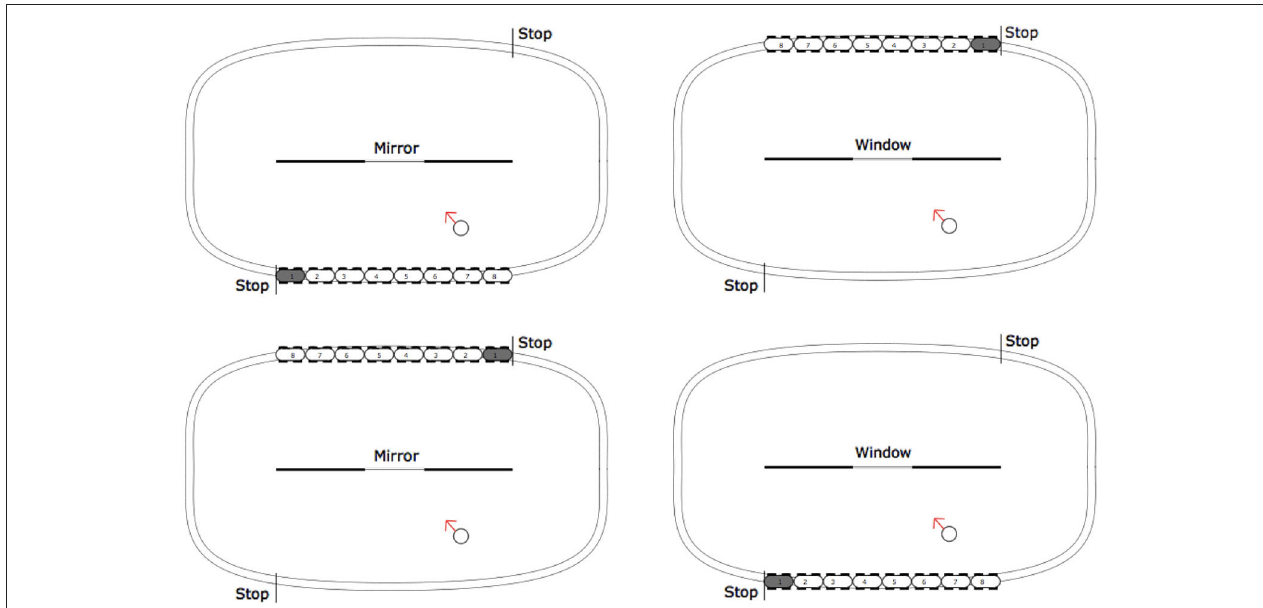
FIGURE 2 | Stimuli used in the four experimental conditions . Top Left: Mirror reflection with movement of the train (MM). Bottom Left: Mirror reflection with static train (MS). Top Right: Window with movement of the train (WM). Bottom Right: Window with static train